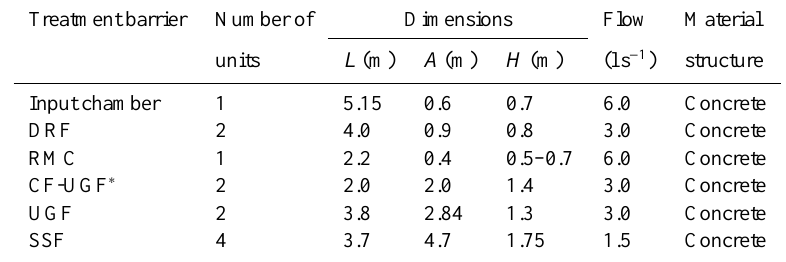
Table 4. Dimensions of each barrier.